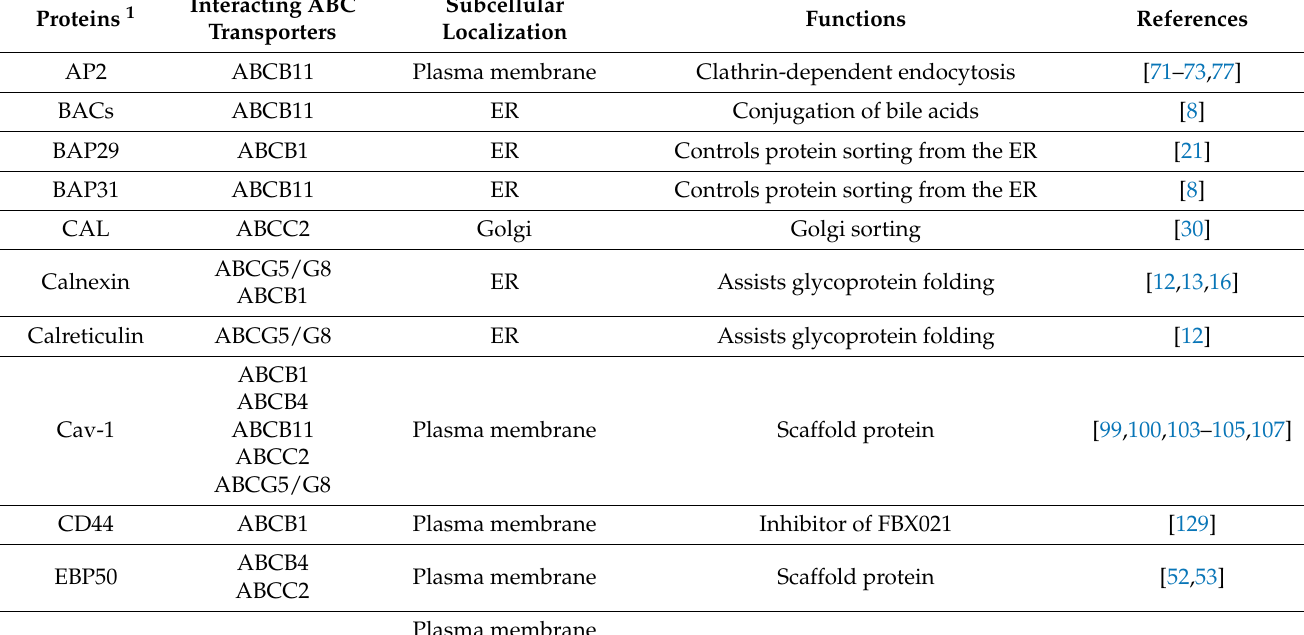
Table 1. Molecular partners of canalicular ABC